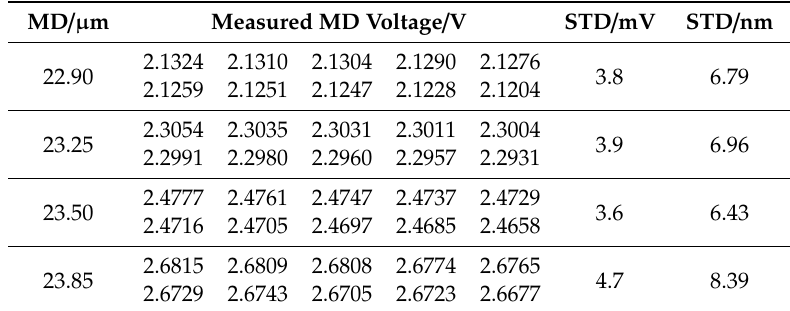
Table 2. Experimental results of repeatability